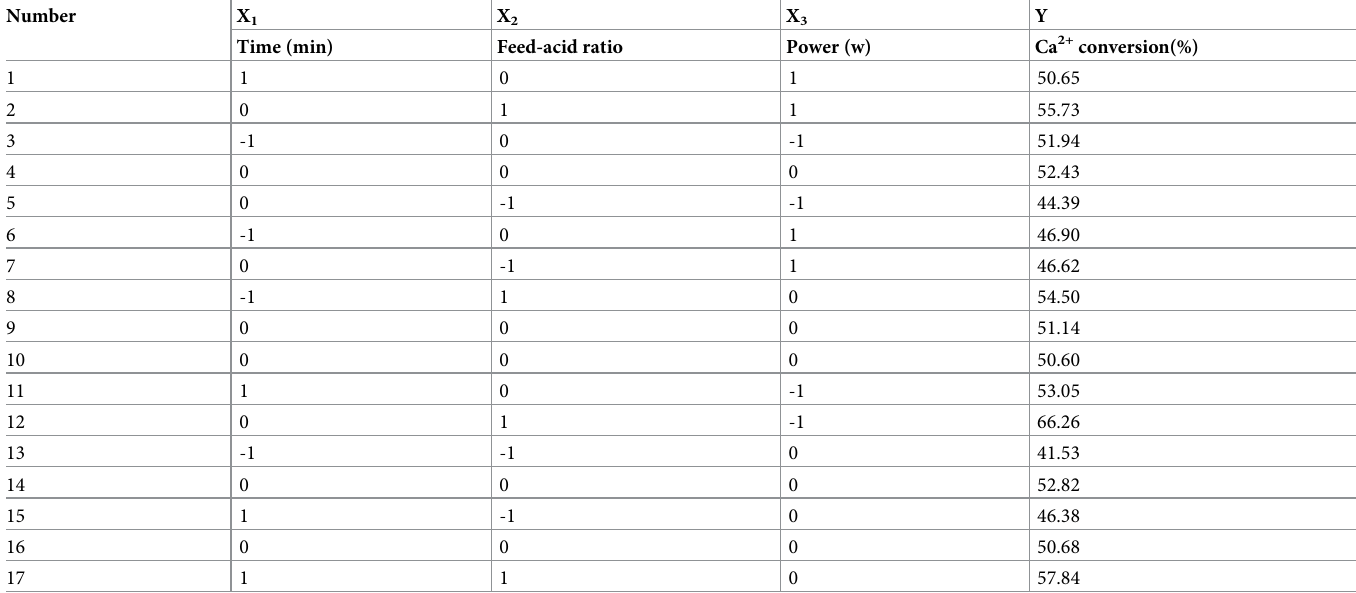
Table 1. Optimization of response surface results.